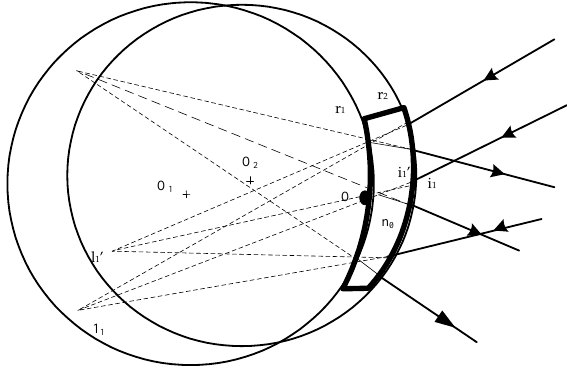
Figure 1. Model of a catadioptric prism.